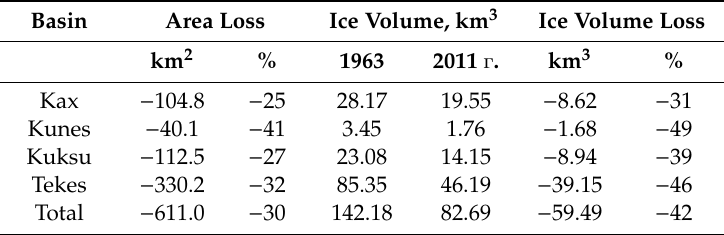
Table 9. Changes in the extent of glacier ice and volume in the main sub-basins of C-IRB between 1963 and 2011 / 12.